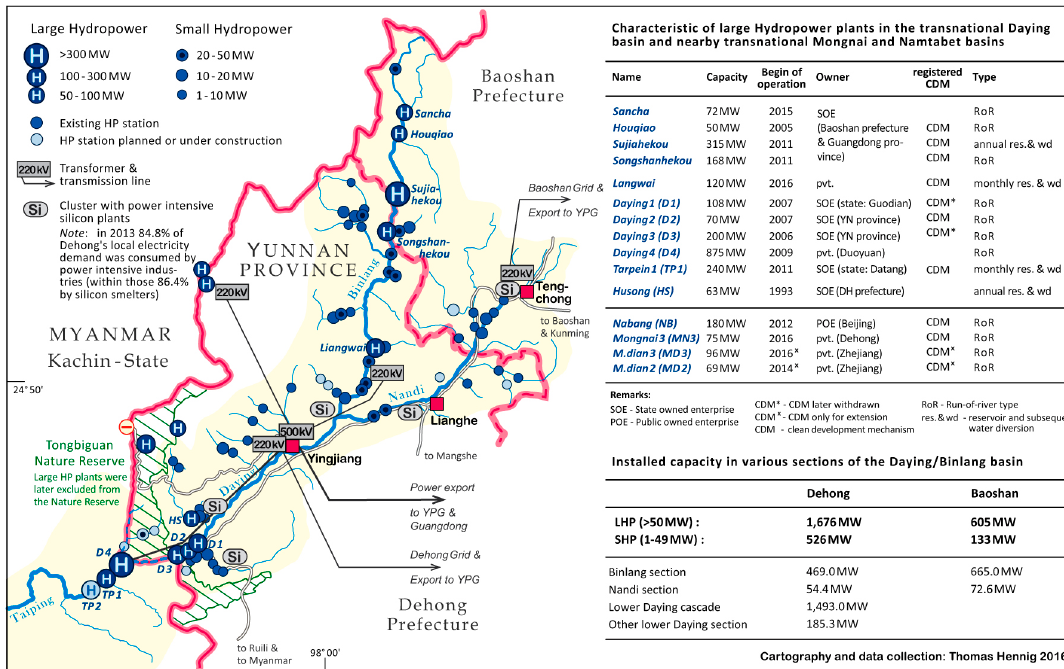
Figure 7. Hydropower development in the transnational Daying Basin. It exemplifies the combination of large and small hydropower as well as a highly fragmented ownership and complex grid structure.